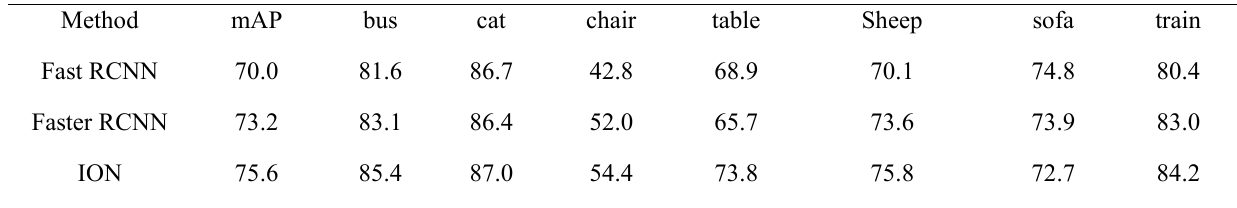
Table 3. Results of CKP-DC and other advanced algorithms on PASCAL VOC2007 test